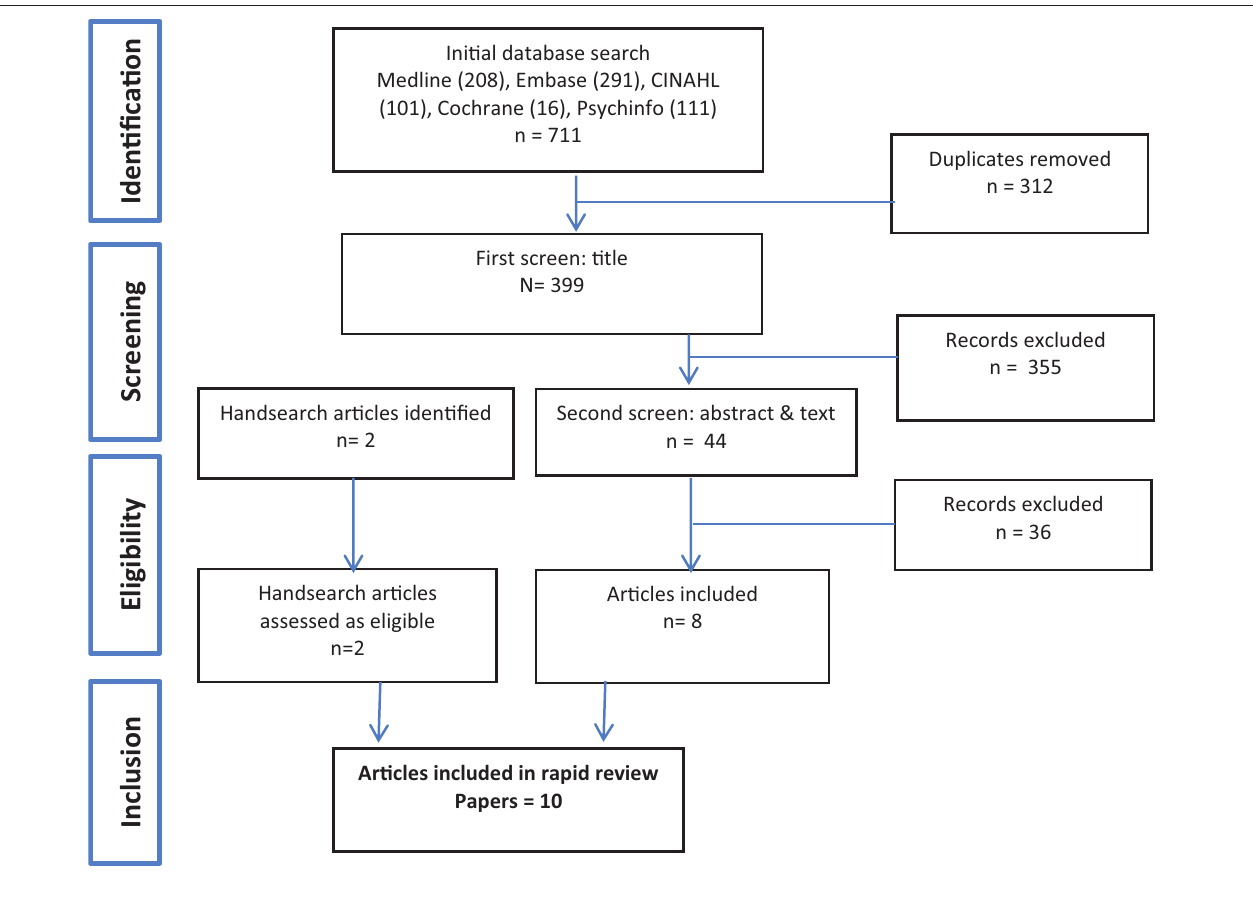
FIGURE 1 | Search strategy